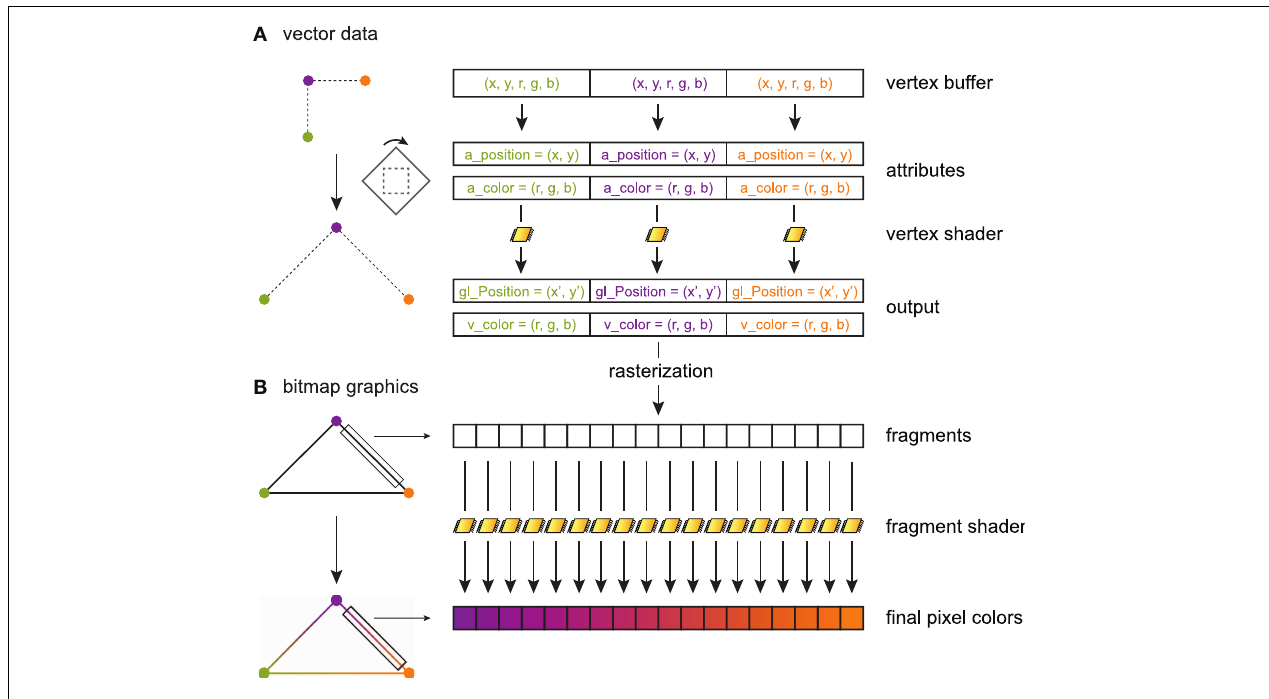
FIGURE 2 | Toy example illustrating shader processing. Three connected line segments forming a triangle are rendered from three vertices. The triangle is linearly transformed, and color gradients are applied to the segments. (A) Three 5D data points are stored in a GPU vertex buffer object. Each point is composed of two scalar coordinates x and y (2D space), and three scalar RGB color components. The vertex shader processes these points in parallel on the graphics card. For each point, the vertex shader returns a point in homogeneous coordinates (here, two coordinates x (cid:2) and y (cid:2) ), along with